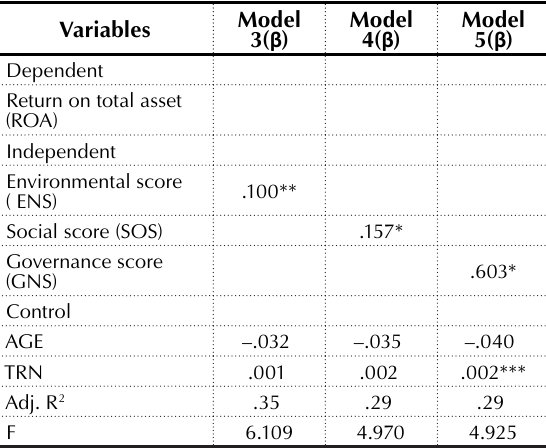
Table 4. Results of the regression analysis for environment, social, and governance as independent variables and turnover as the